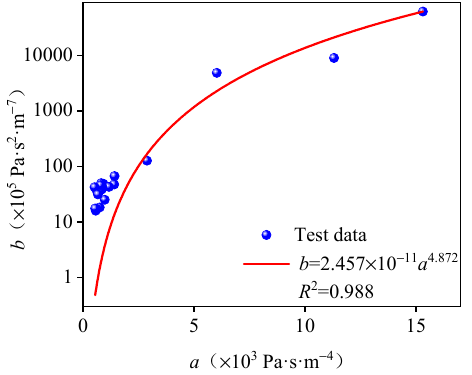
Figure 7. Relationship between the non-linear b and linear a term coefficients.